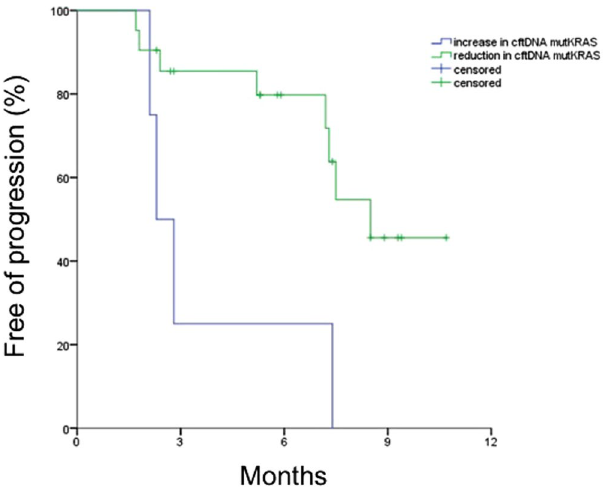
Figure 1. PFS according to early mut KRAS cftDNA variation (increase vs. reduction).